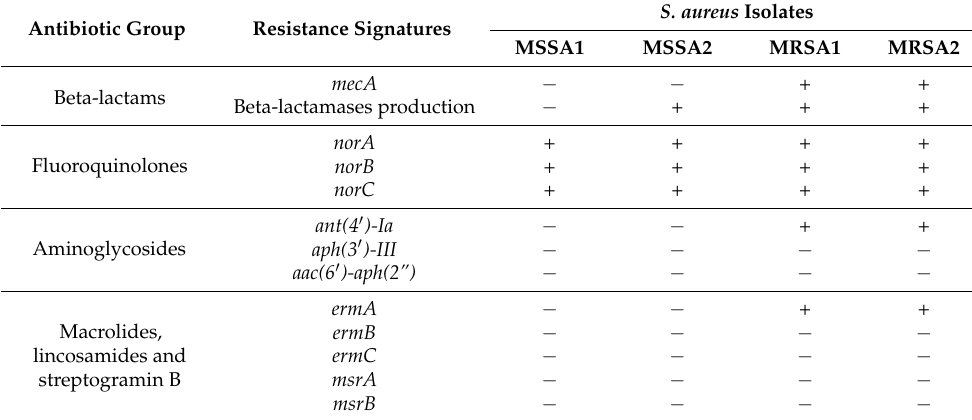
Table 2. Resistance signatures of S. aureus isolates. Antibiotic